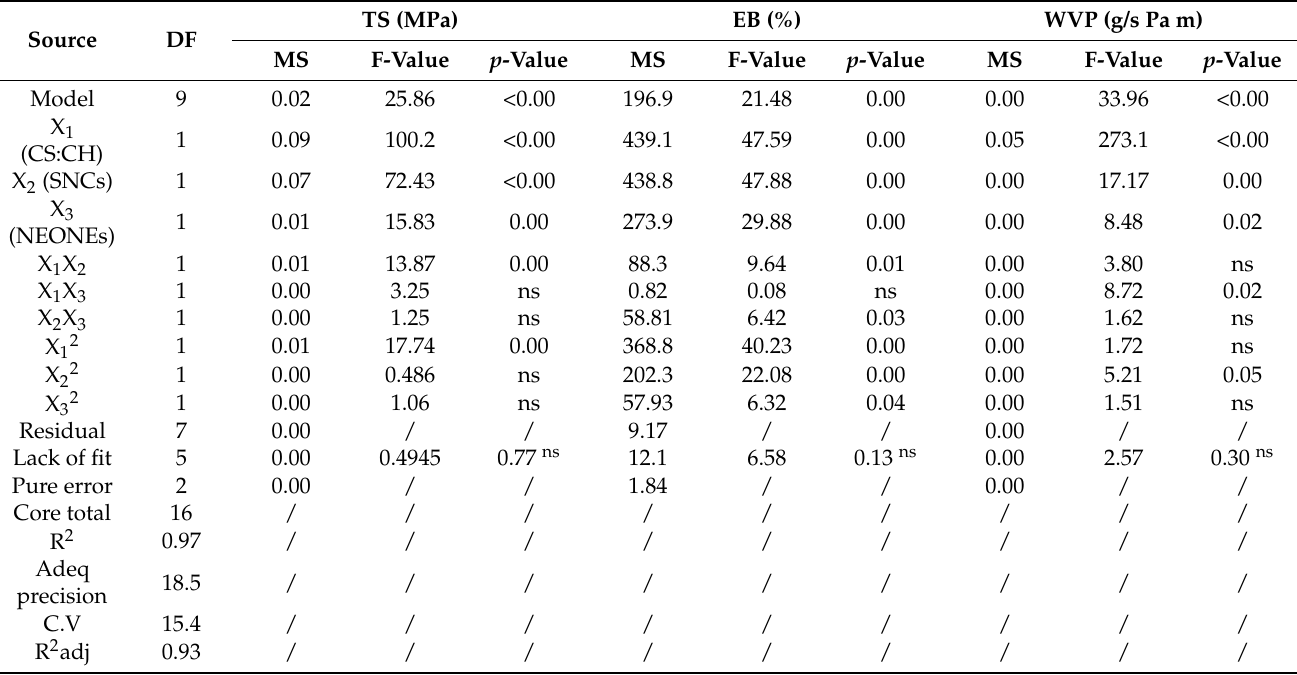
Table 5. ANOVA table for the second-order polynomial models constructed for each mechanical and barrier response variable. Source